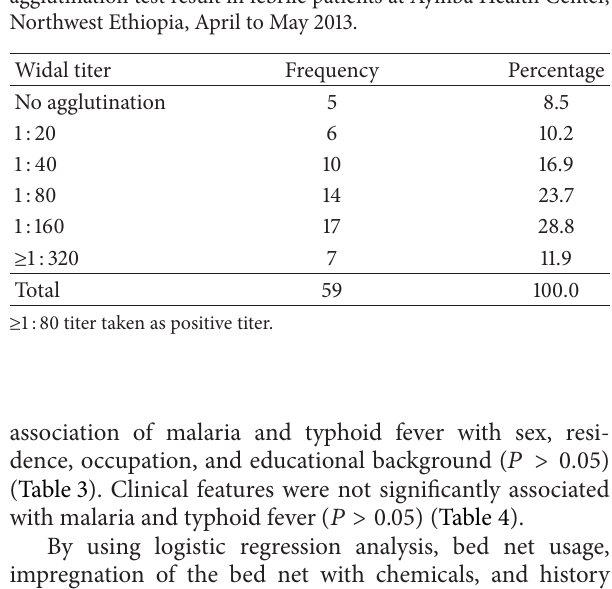
Table 2: The frequency distribution of titration result among